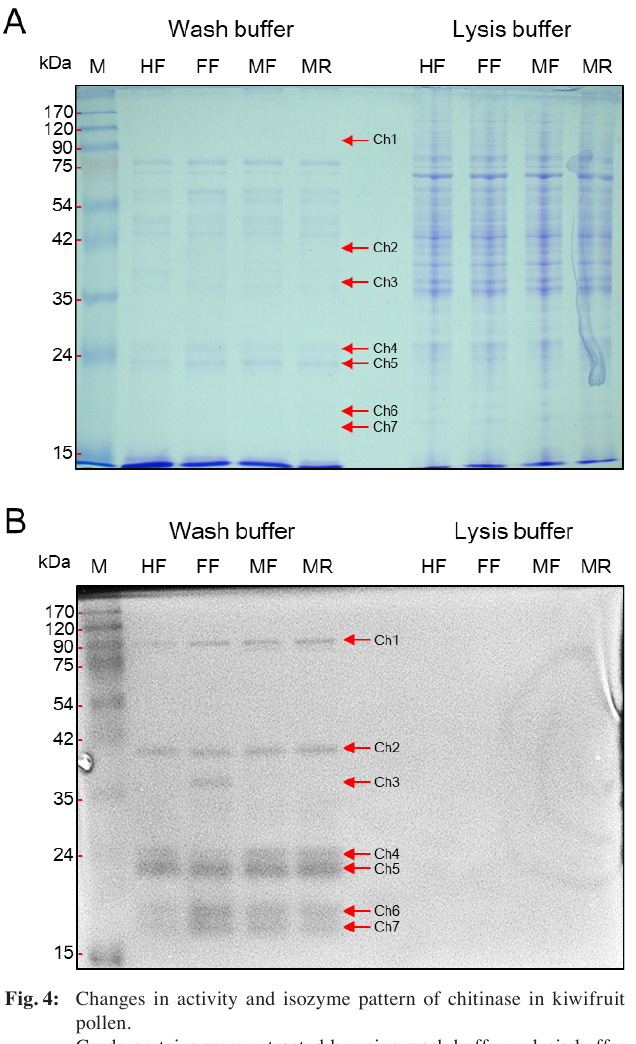
Fig. 4: Changes in activity and isozyme pattern of chitinase in kiwifruit pollen. Crude proteins were extracted by using wash buffer or lysis buffer and loaded into each lane of two different 10% (w/v) gels with or without 0.01% (w/v) glycol chitin embedded. Following electropho- resis, protein bands were visualized by CBB staining (A), and indi- vidual chitinase isozymes were detected by chitinase active staining (B). M, size marker; HF, heat-treated frozen storage; FF, fresh frozen storage; MF, moisture-treated frozen storage; MR, moisture-treated RT storage. Arrows indicate seven chitinase